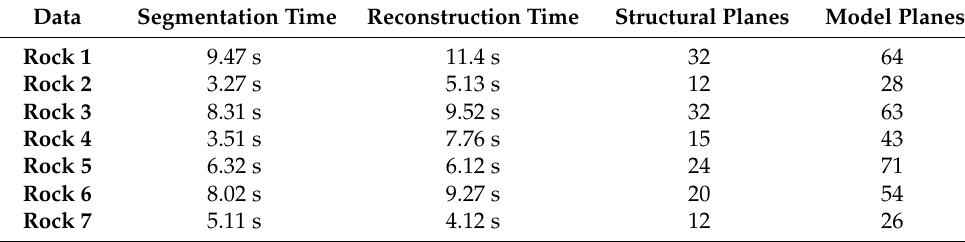
Figure 18. Reconstruction results of Rock 7. Table 7. Reconstruction information of all